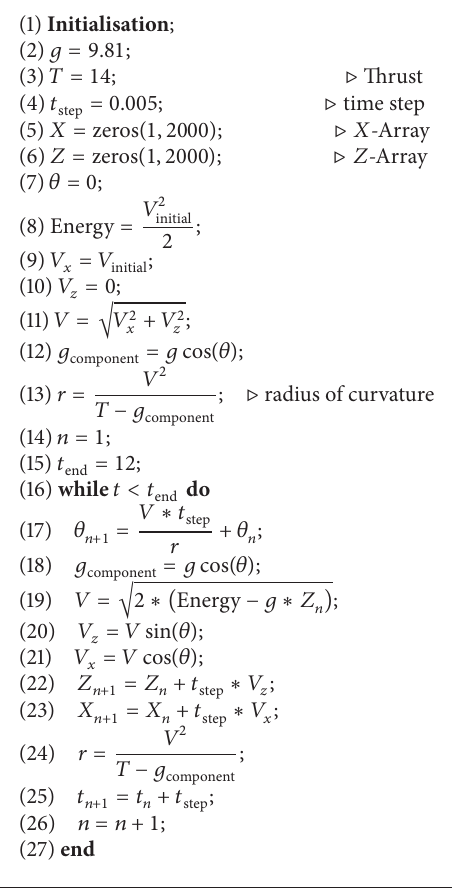
Algorithm 1: Constant thrust.